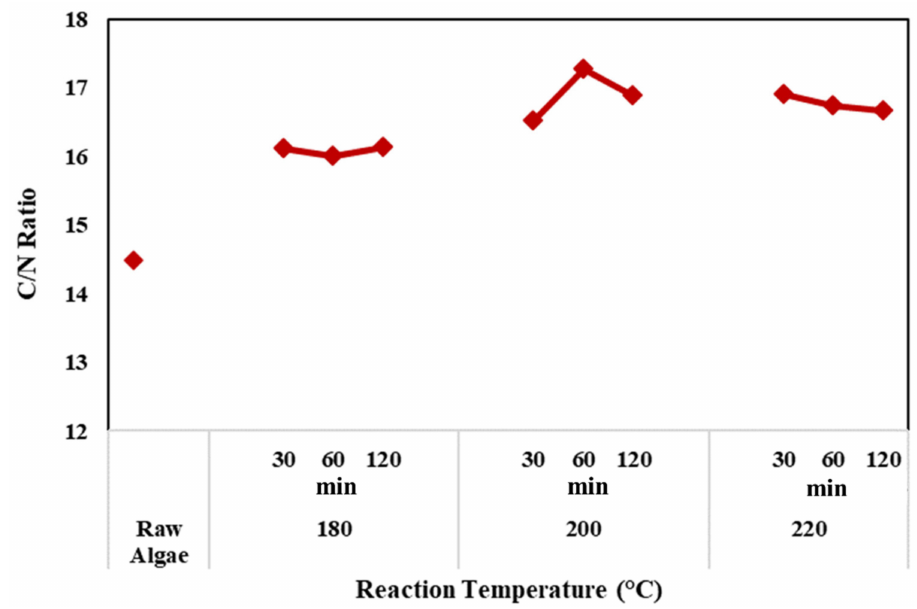
Figure 9. Effect of the process conditions on the C/N ratio of hydrochar in the